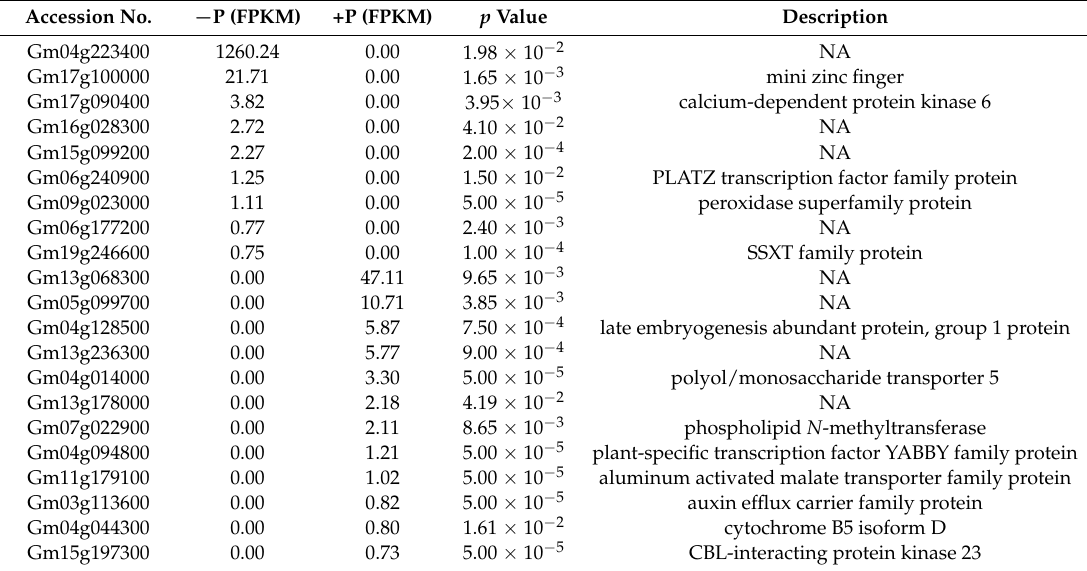
Table 1. Differentially expressed genes where transcripts were found only in Pi-deprived leaves (PDL) or Pi-sufficient leaves (PSL) after 24 h Pi deprivation. Expression level of each gene was measured in terms of fragments per kilobase of transcript per million mapped reads (FPKM). Gene functional descriptions were shown according to soybean genome annotation (V2.0). Accession number “Glyma.” is named as “Gm” for short. − P refers to PDL and +P refers to PSL. NA: no annotation. Accession